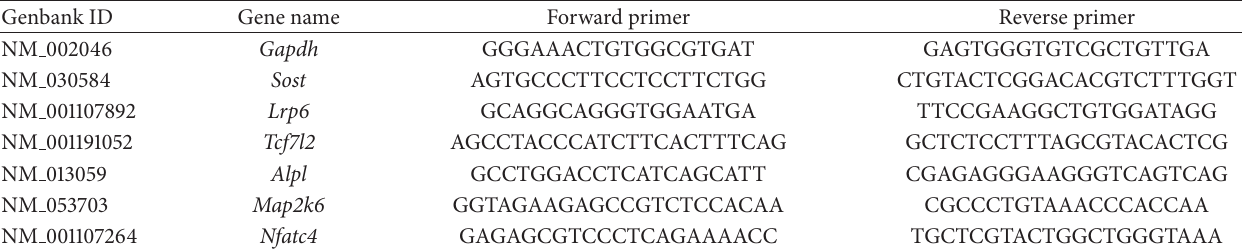
Table 1: Primers used for qPCR analysis.